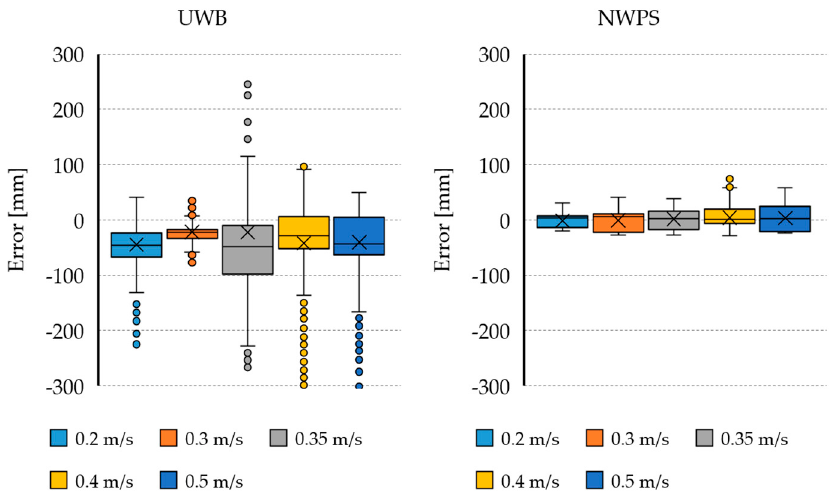
Figure 7. Estimation errors of the distance to the wall in the dynamic test, for the UWB and the proposed NWPS. Conveyor belt considered as ground truth.